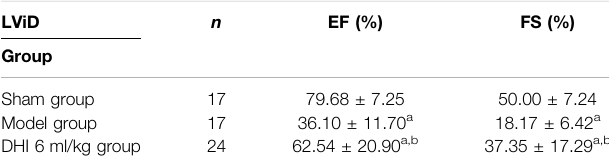
TABLE 2 | The effect of DHI on ejection fraction and left ventricular short axis shortening rate in acute myocardial infarction model rats ( (cid:1) x ±s). LViD